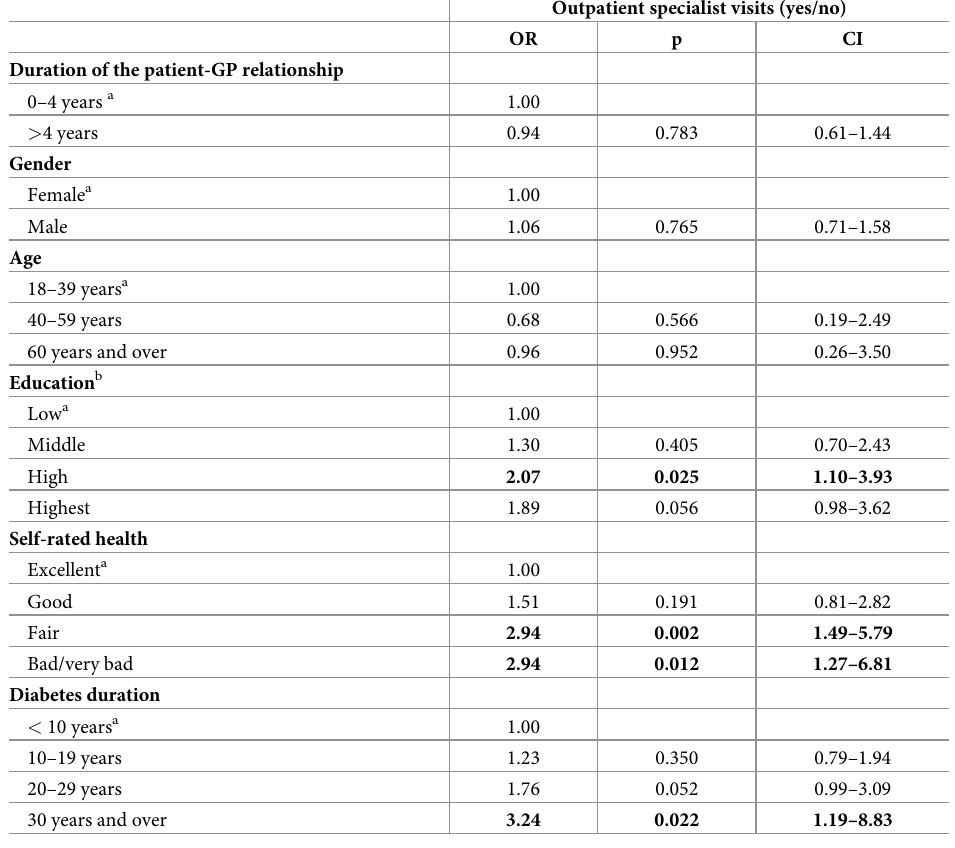
Table 3. Probability of outpatient specialist visits according to duration of the patient-GP relationship (N =